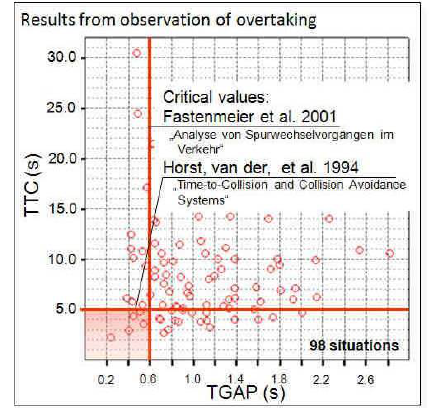
Fig. 3 Critical values for Time Gap an Time to Collision